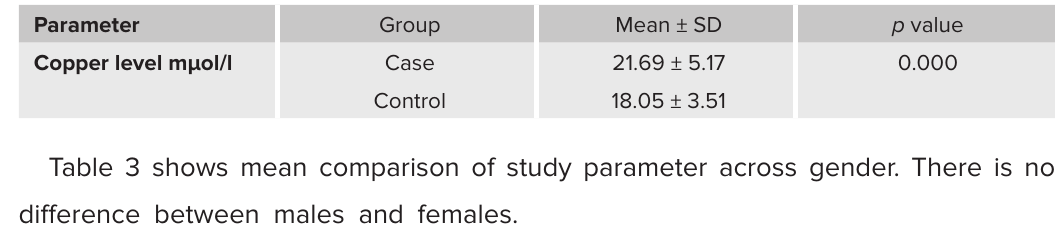
Table 2: Mean Comparison of Study Parameters in Case versus Control Groups.